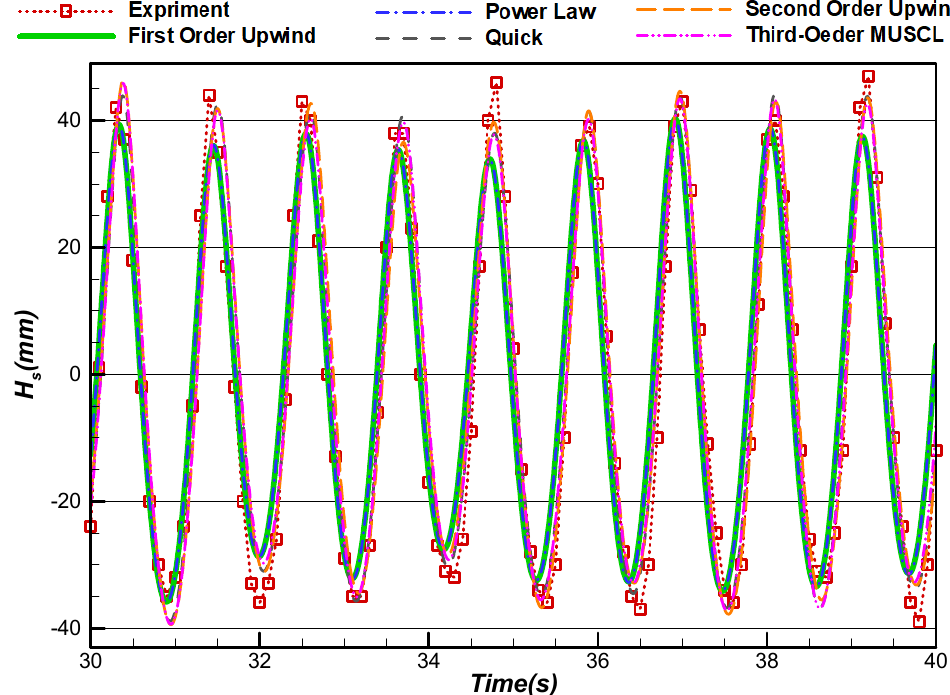
Figure 13. Independence checks of the discretization scheme.